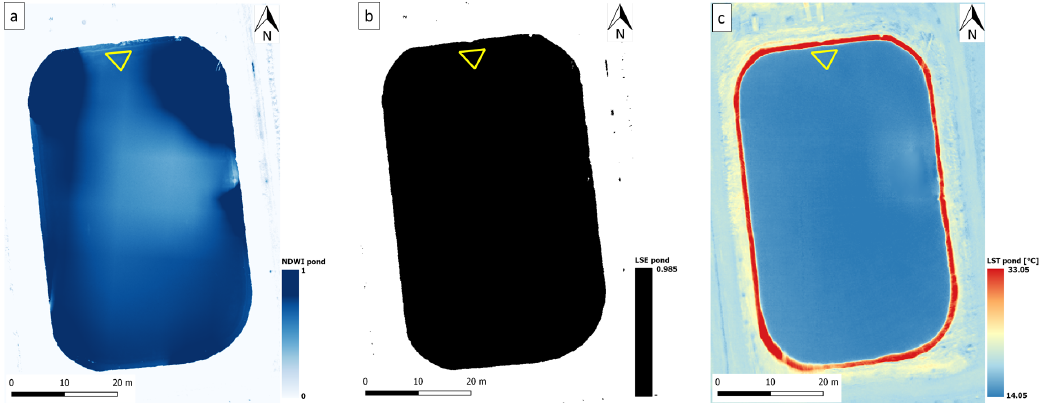
Figure 9. The NDWI map ( a ) for the border of the water surface, the LSE map of the water surface ( b ), and the retrieved water temperature LST pond ( c ). The yellow triangle marks the area in which we measured reference temperatures with thermocouples to validate the thermal data 11 April 2018, 13:32